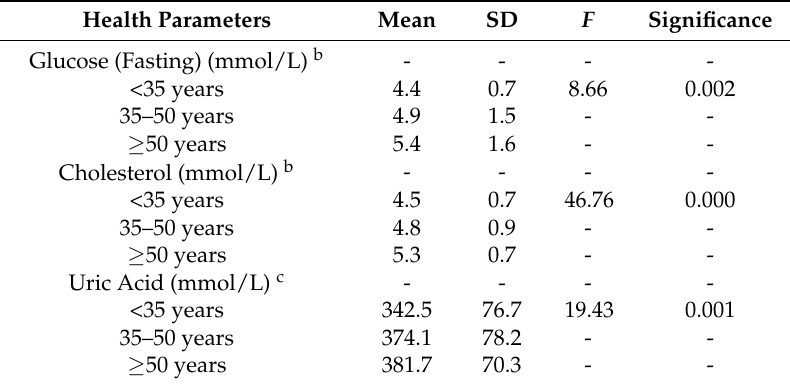
Table 3. Comparison of means of health parameters in age groups a .